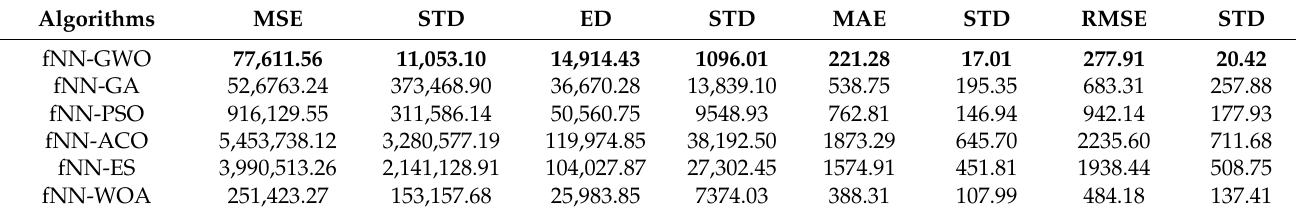
The comparison of fNN-GWO and other meta-heuristics for hourly daily and total daily load consumption is presented in this subsection. Table 5 illustrates the results of fNN-GWO and other meta-heuristics for the hourly daily load consumption. As shown, the fNN-GWO gained the best results in all measures, followed by fNN-WOA, fNN-GA, fNN- PSO, fNN-ACO, fNN-ES, and fNN-WOA, respectively. The difference between fNN-GWO and the nearest meta-heuristic (fNN-WOA) were 173,811.71, 11,069.45, 167.11, 277.91, and 206.27 for MSE, ED, MAE, and RMSE, respectively. The error analysis of the hourly daily load consumption for fNN-GWO, fNN-GA, fNN-PSO, fNN-ACO, fNN-ES, and fNN-WOA methods can be found in Figures 9–14, respectively. Table 5. A comparison between fNN-GWO error forecasting results for hourly daily load consumption, and other meta- heuristics